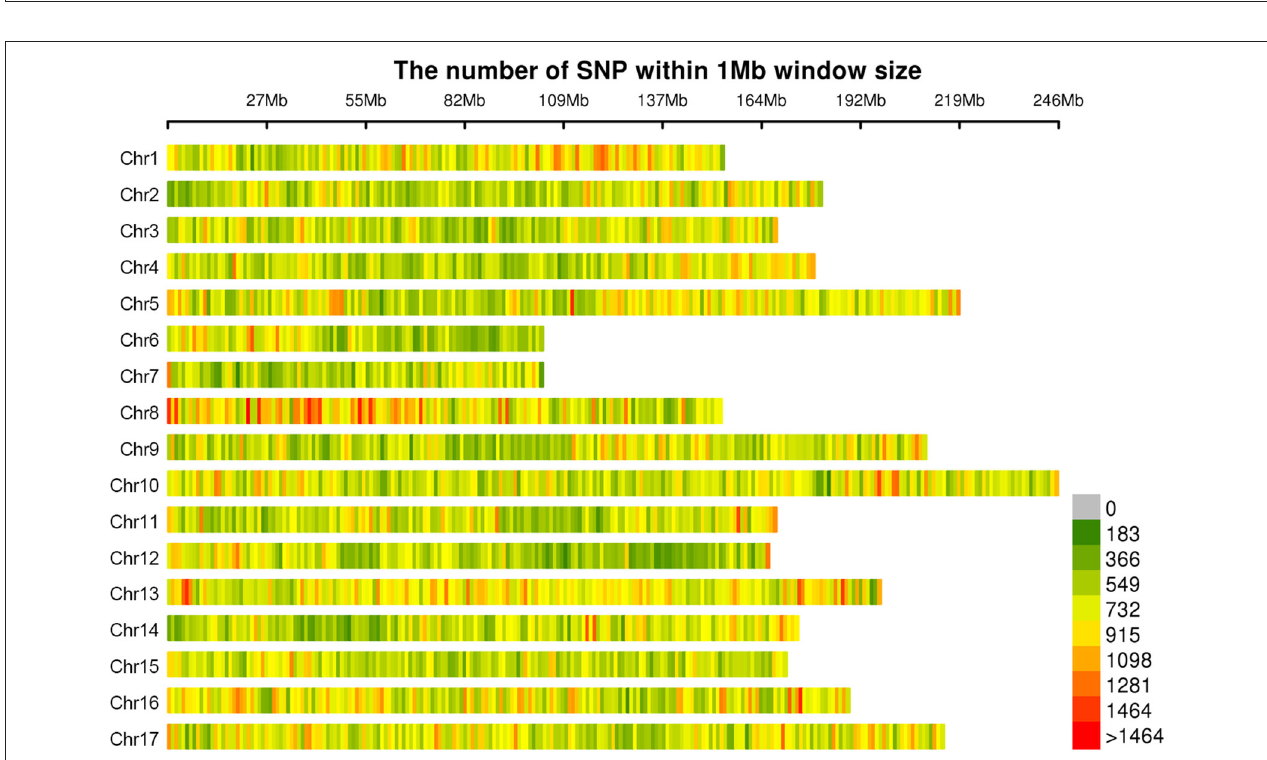
FIGURE 4 | Distribution of all 2,124,143 single nucleotide polymorphisms (SNPs) on sunflower genome. The colors indicate the number of SNPs within a 1Mb window.